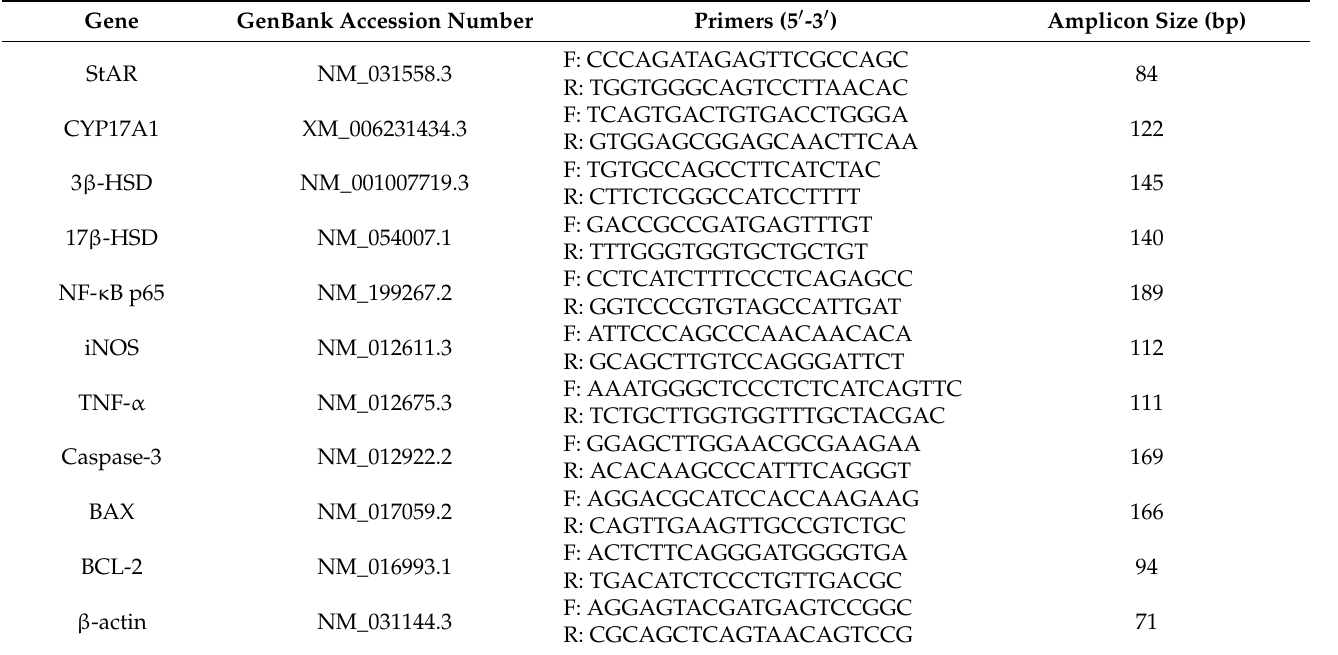
Table 1. Primers used for